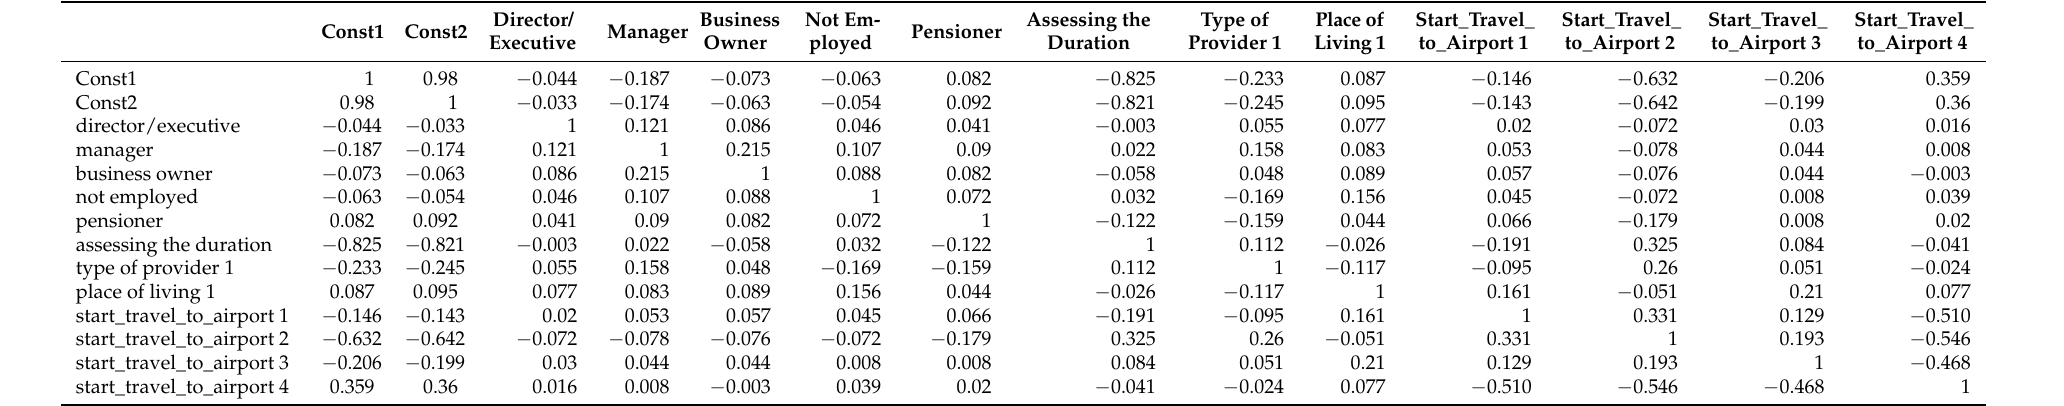
Table A2. Correlation matrix for the ordered logit (dependent variable: sustainable transport